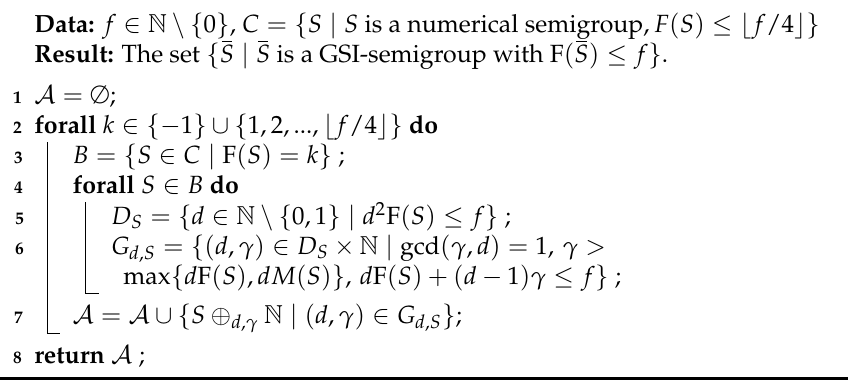
Algorithm 1: Computation of the set of GSI-semigroups with Frobenius number less than or equal to f .